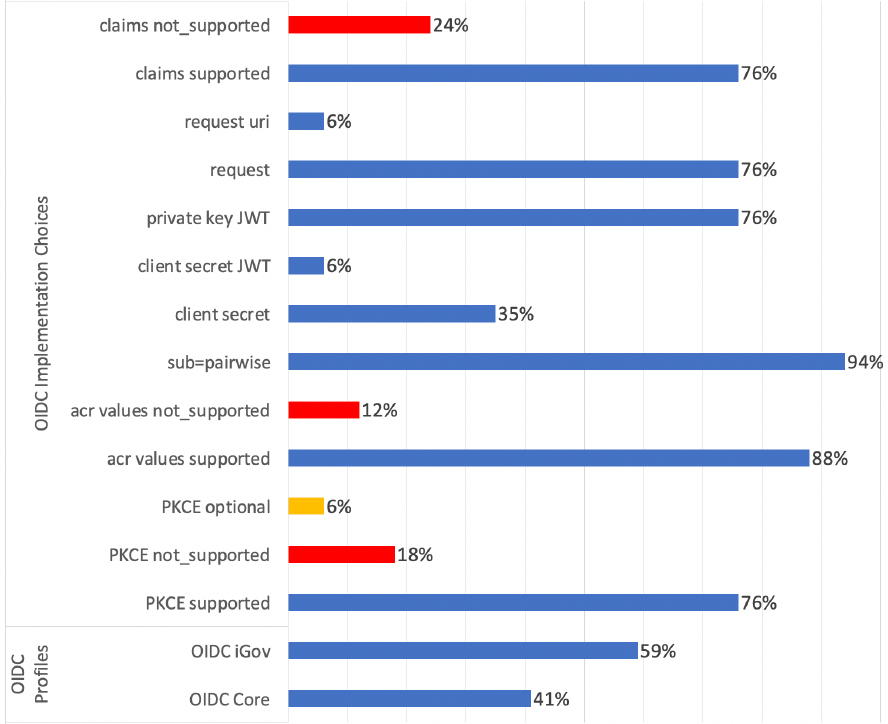
Figure 5. Overview of OIDC profiles and OIDC implementation choices adopted by